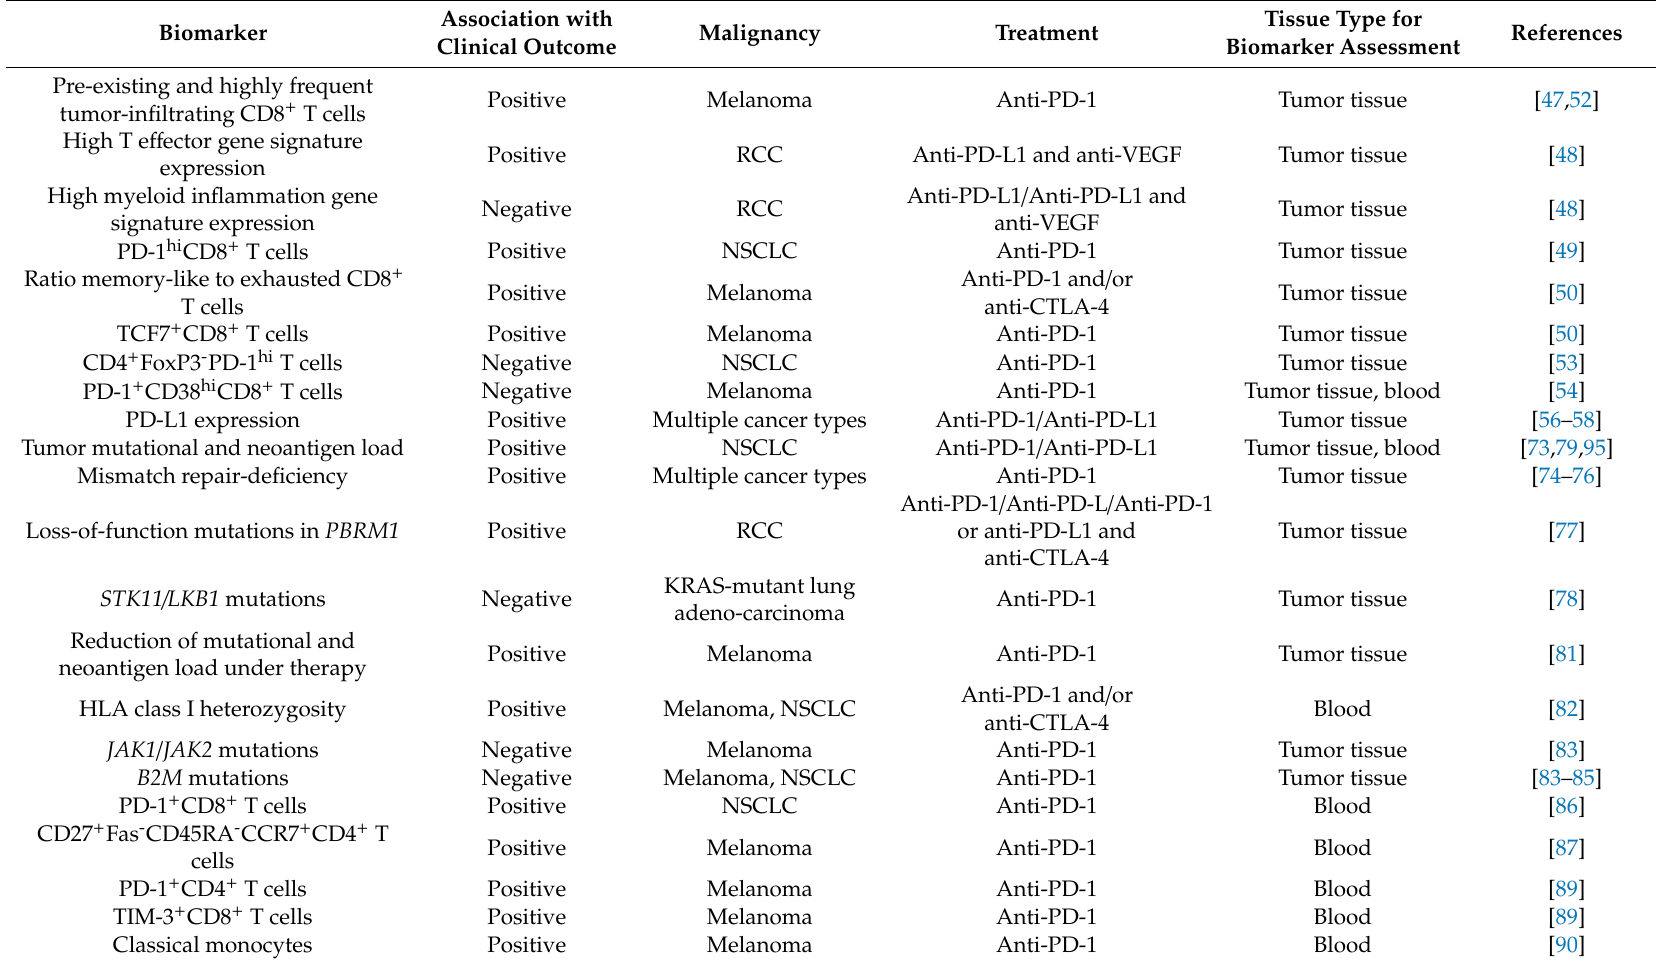
Table 1. Biomarkers associated with clinical response to anti-PD-1 or anti-PD-L1